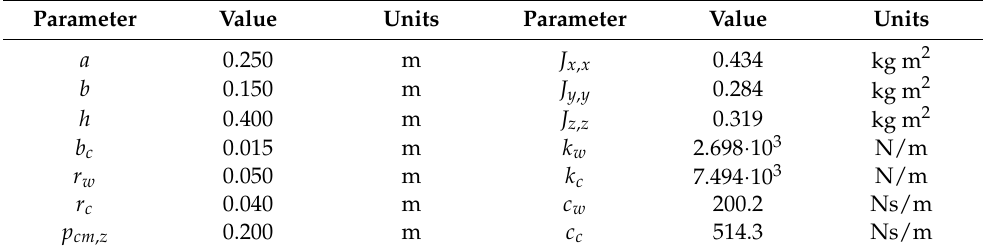
Table 2. Robot parameters.